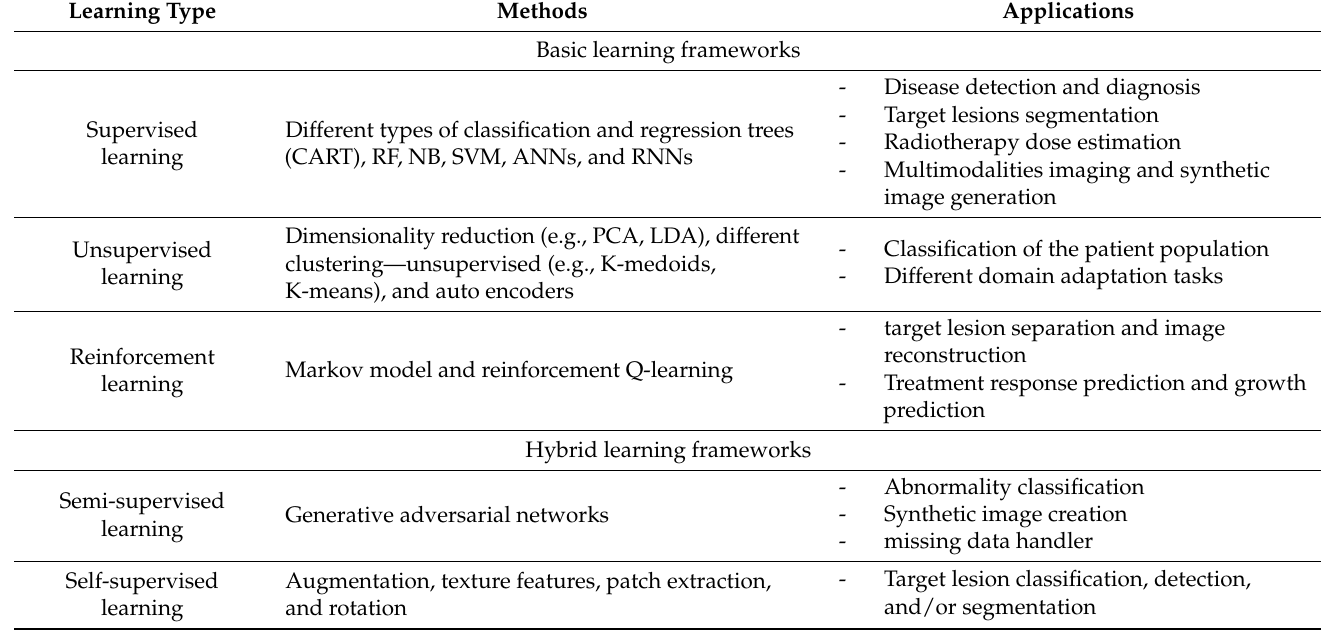
Table 5. Learning outlines and approaches with some popular techniques in the field of medical